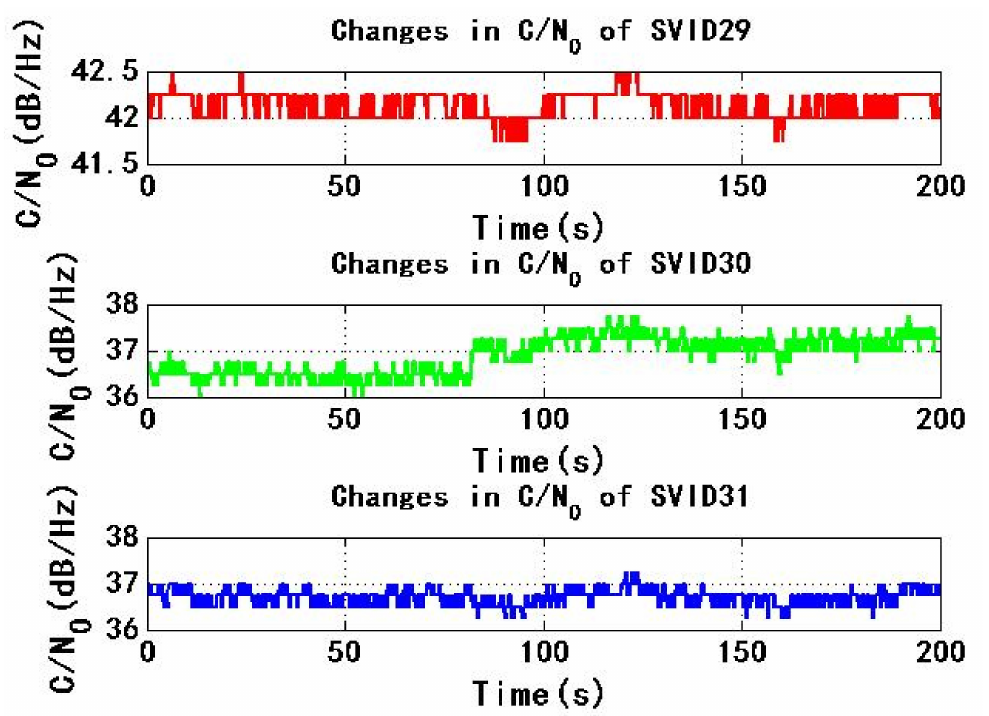
Figure 16. Changes in C / N 0 of SVID29, 30, 31 in experiment